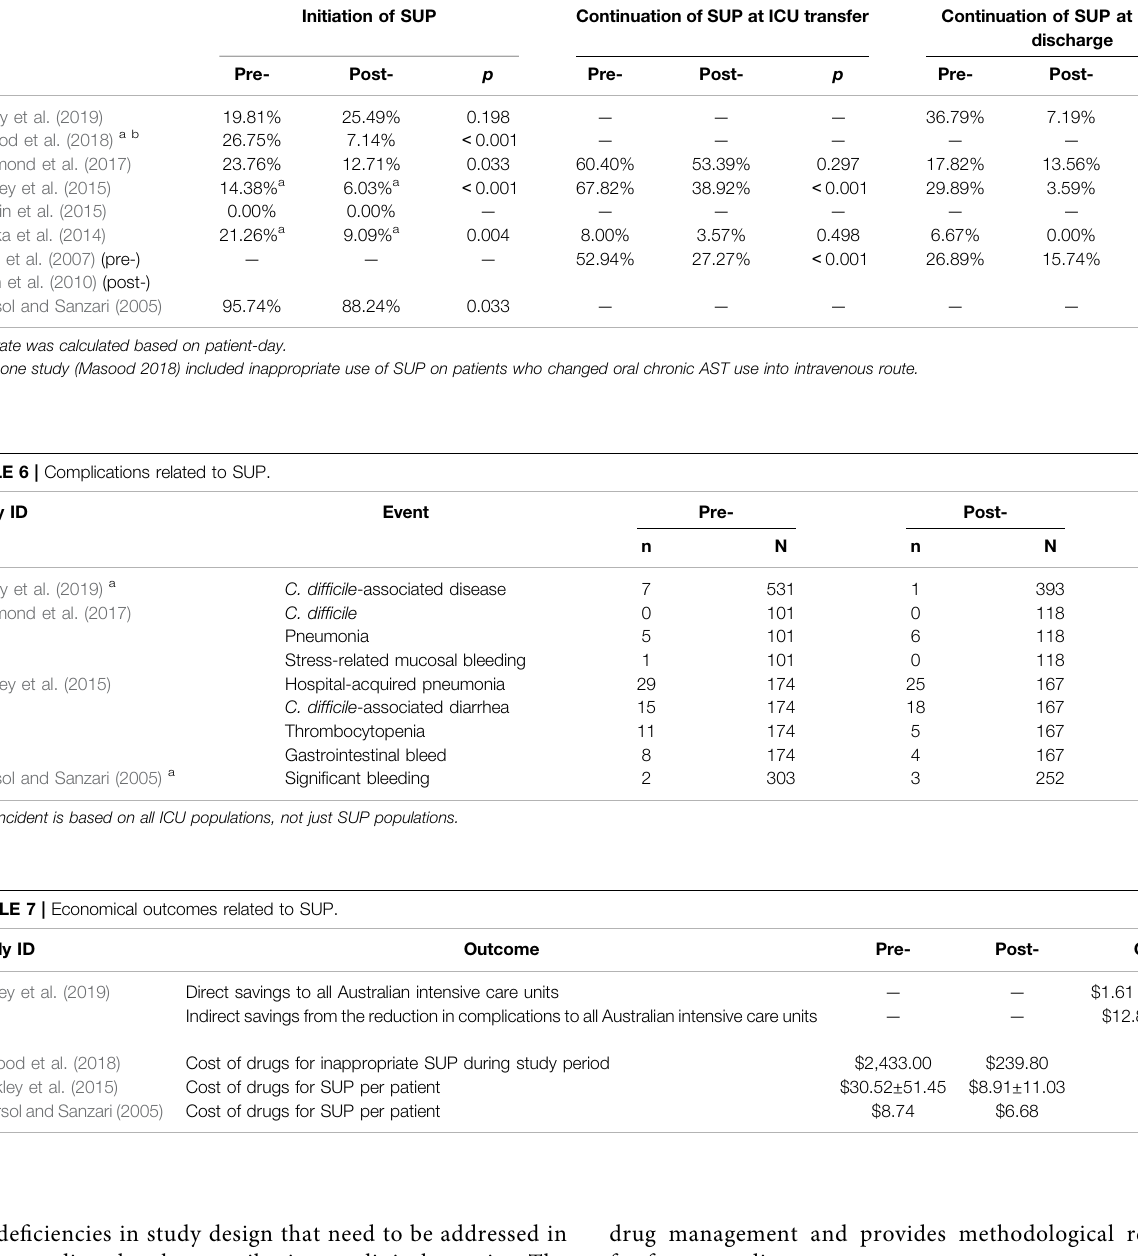
TABLE 5 | The rate of inappropriate use of SUP pharmacotherapy. Study ID